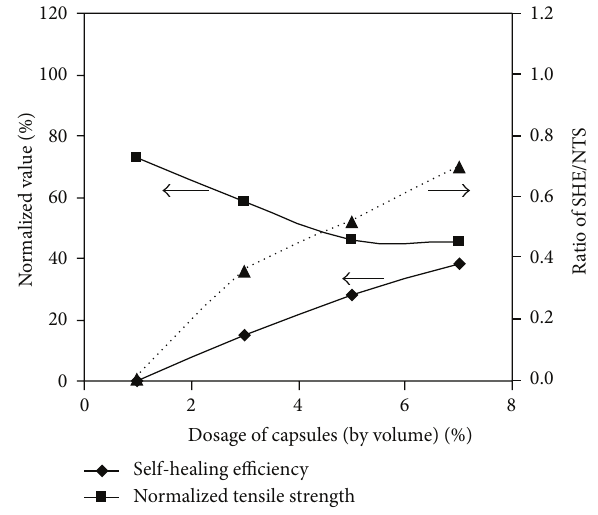
Figure 17: Comparison of self-healing efficiency and decrease of tensile strength (SHE/DTS is the ratio of self-healing efficiency to the decrease of normalized tensile strength). The triangles and the dotted curve refer to ratio of SHE/NTS of the vertical axis on the right